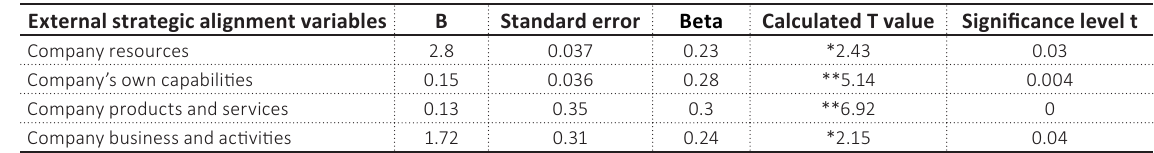
Table 7. Impact of external strategic alignment on company image and reputation External strategic alignment variables